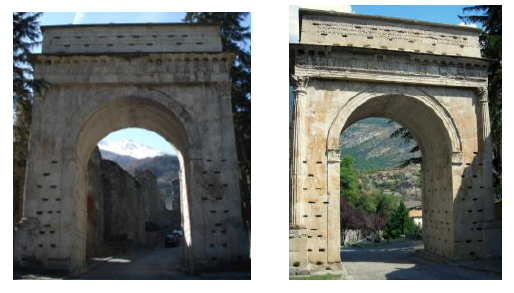
Figure 5. The arch of Augusto in Susa